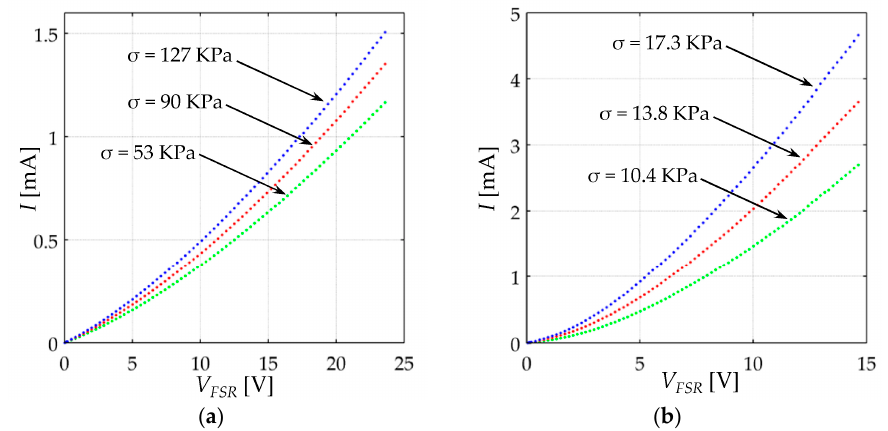
Figure 11. Current-Voltage ( I-V FSR ) relationship at different stresses for the sensors: ( a ) FlexiForce A201-1 and ( b ) Interlink FSR 402.